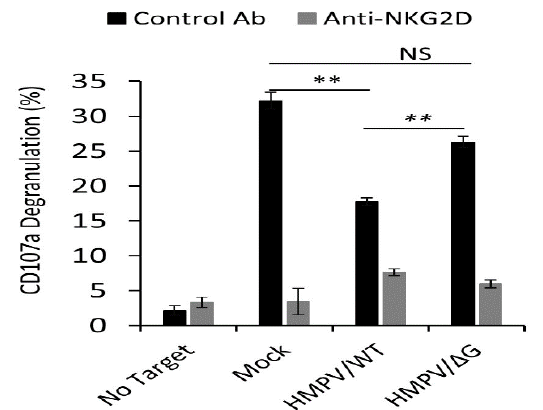
Figure 2. HMPV infection decreases natural killer (NK) cell activation. Primary IL-2-activated NK cells were incubated with the target cells, mock-infected A549 cells (Mock), HMPV / WT-infected A549 cells (HMPV / WT), and HMPV / ∆ G-infected A549 cells (HMPV / ∆ G) at a 1:1 ratio with or without blocking antibodies against the natural killer group 2D (NKG2D) receptor that were included during the infection period. CD107a expression was assessed. The experiment included two independent NK cell donors. The experiment without NKG2D blocking and with the blocking of anti-NKG2D were repeated three times. Statistical analysis was performed on all combined data using two-way ANOVA ( n = 3). p values were estimated using a post-hoc test. ** p < 0.005. NS—Not significant.